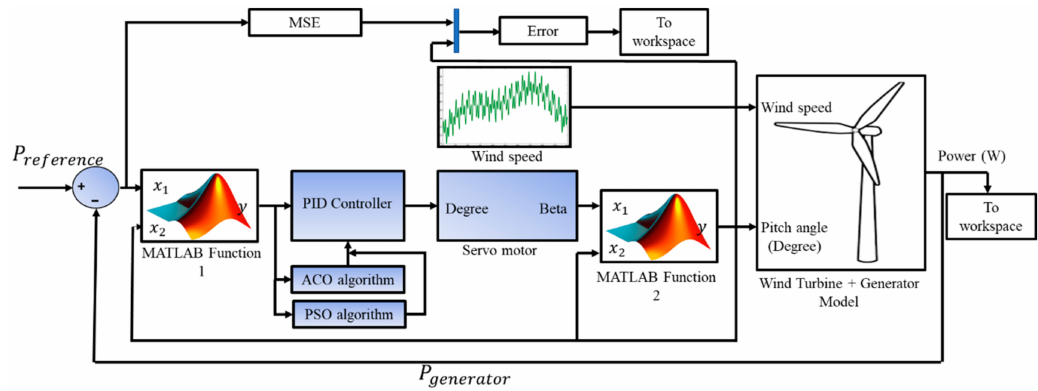
Figure 10. Wind turbine MATLAB / Simulink